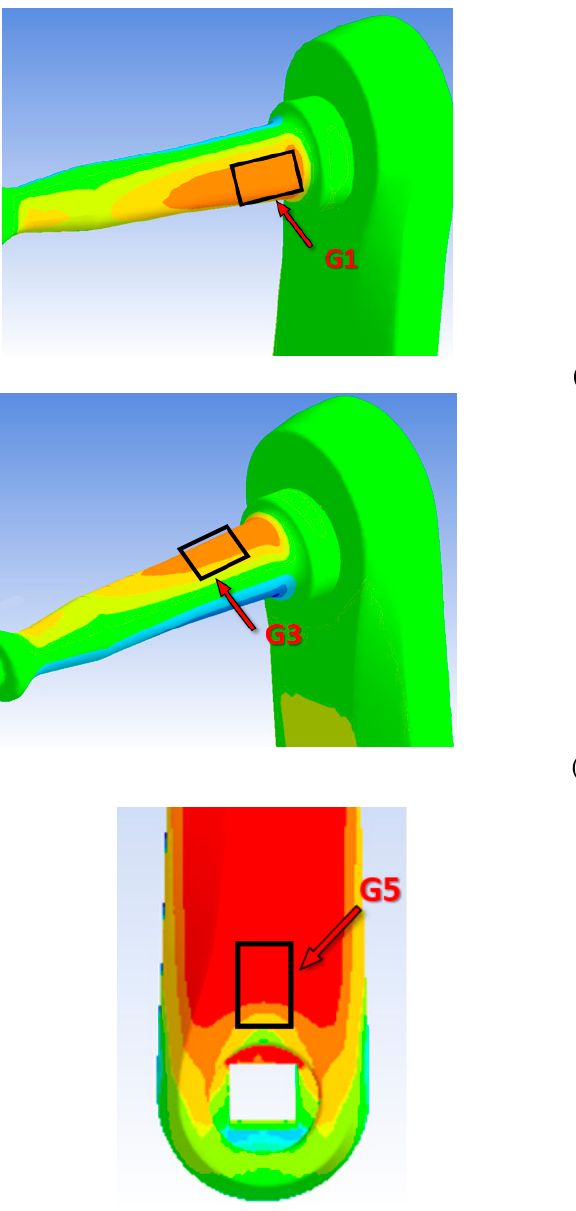
( b ) Figure 6. Diagram of the elements used in the PCB. ( a ) Power supply and data storage circuit with voltage regulator. ( b ) Half-Wheatstone bridge measurement circuit with low-pass filter. Table 1. Microdeformations measured by the gauges when applying a force of 98.1 N in each direc- tion. Wheastone Bridge